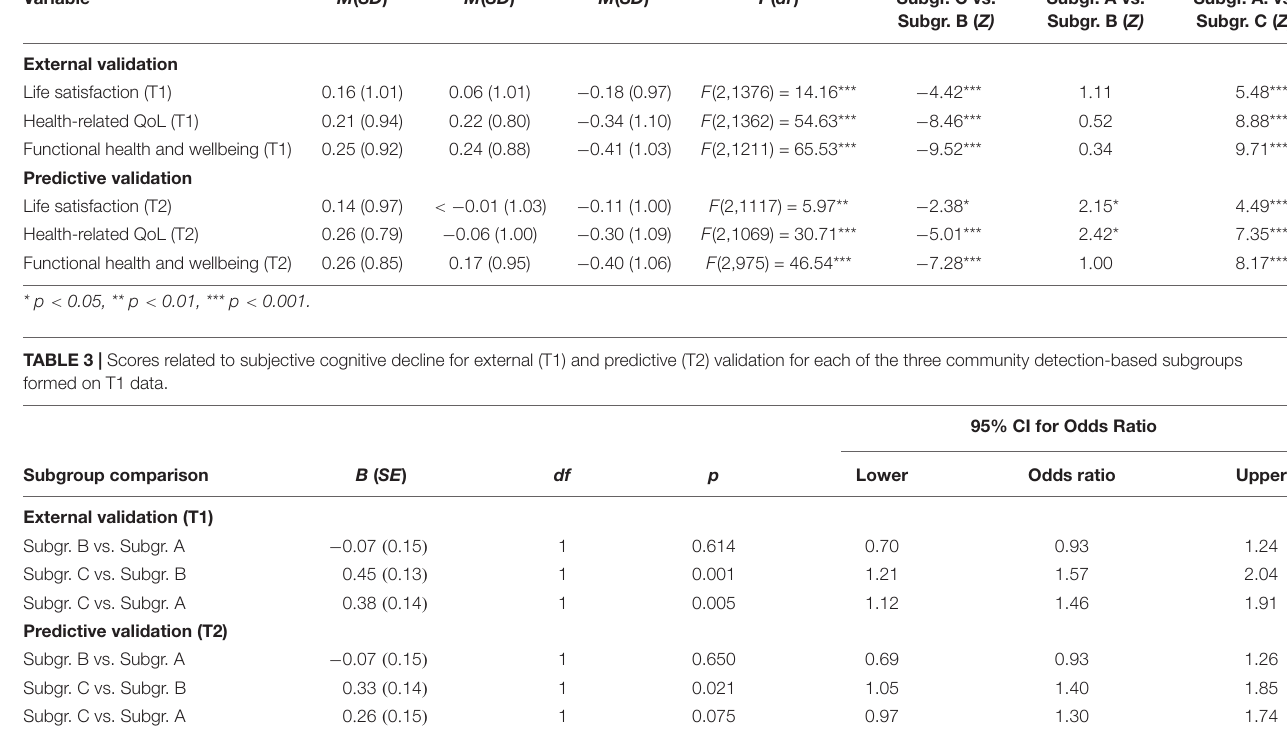
TABLE 2 | Scores for external (T1) and predictive (T2) validation measures for each of the three community detection-based subgroups formed on T1 data. Subgroup Subgr. A Subgr. B